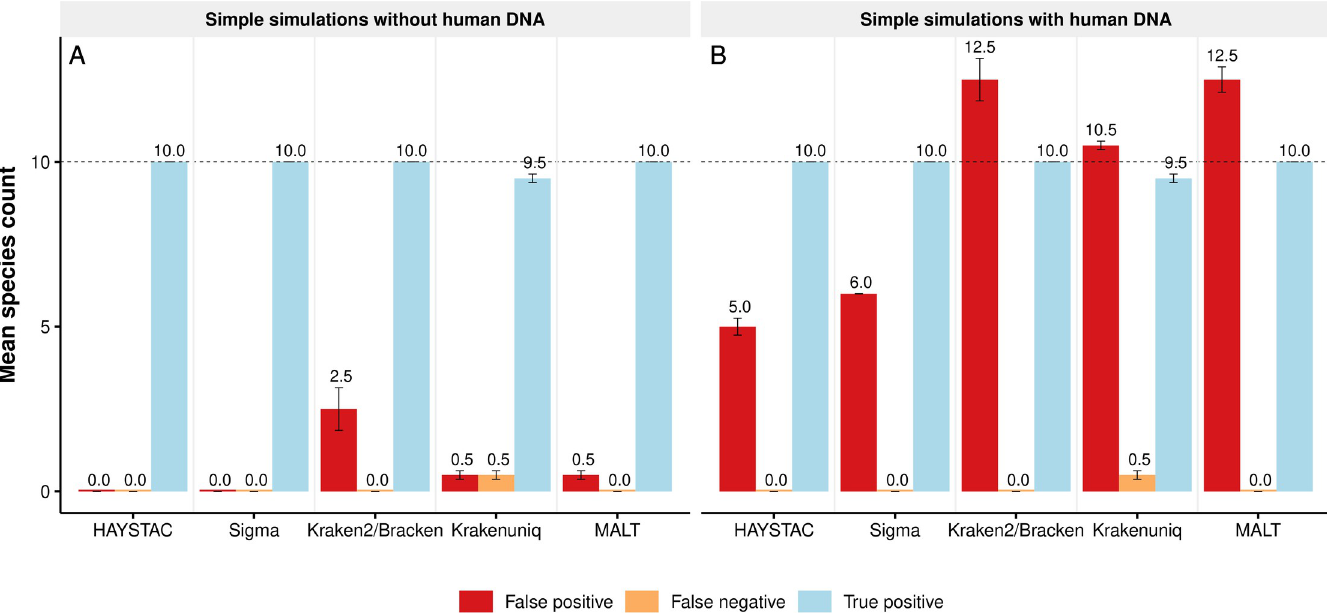
Fig 3. Accuracy of HAYSTAC and other methods for a simple simulation. Bar plot showing the mean count of false positives (red), false negatives (orange), and true detected species (blue) for two versions of the simple simulations dataset, each with two replicates: (A) without human DNA contamination ( n = 2); and (B) with human DNA contamination ( n = 2). The dotted line shows the number of simulated species in each set of samples ( i . e ., the maximum true positive; n = 10), and numbers above the error bars indicate the mean species count in each category. For the simulation without human contamination, HAYSTAC outperforms Kraken2/Bracken, KrakenUniq and MALT, and performs equally with Sigma ( i . e ., no false positives or false negatives). For the simulation with human contamination, HAYSTAC outperforms all four other methods. All of the 5 false positive species identified by HAYSTAC are known to contain human sequences in their reference genomes [37], confounding any analyses which do not explicitly filter human